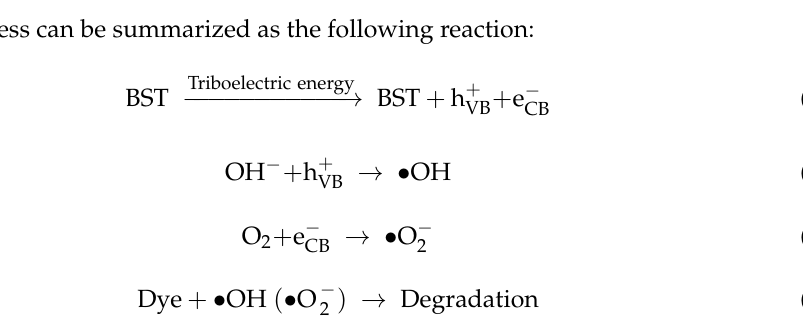
Figure 8. Mechanism diagram of tribocatalysis of BST nanopowders.